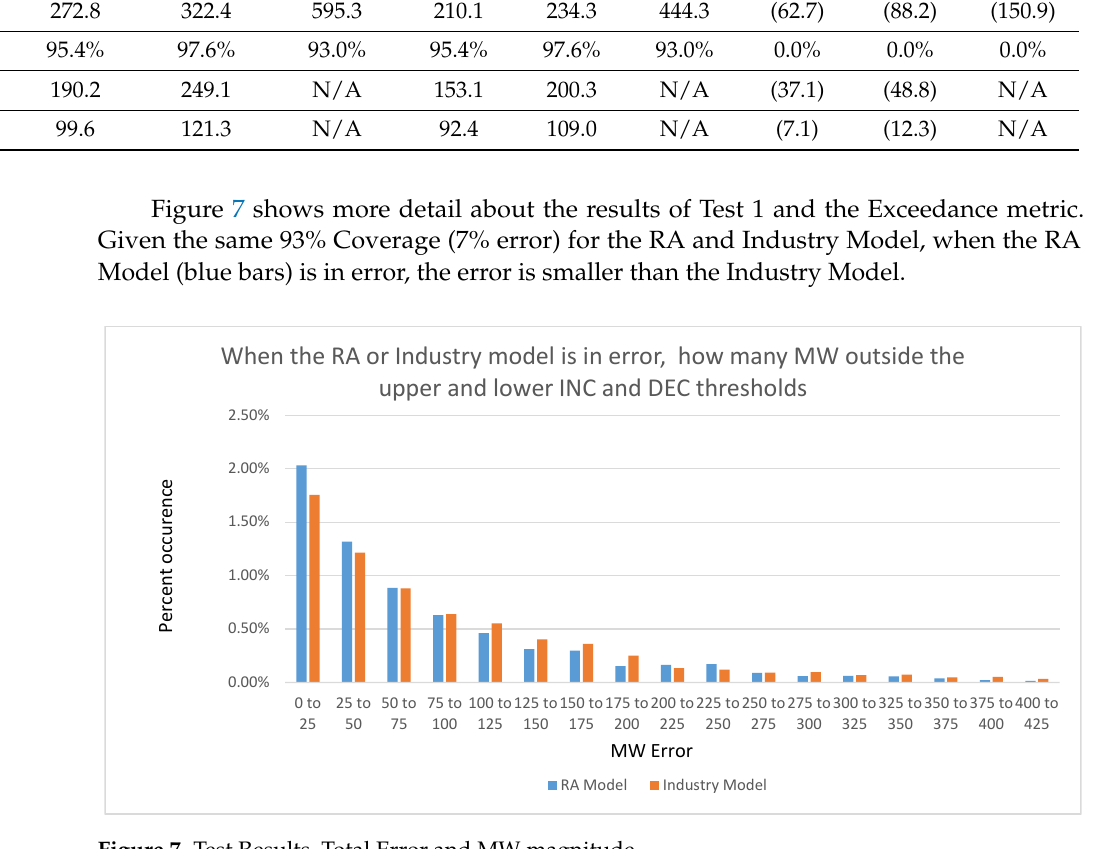
Table 13. Test Results.